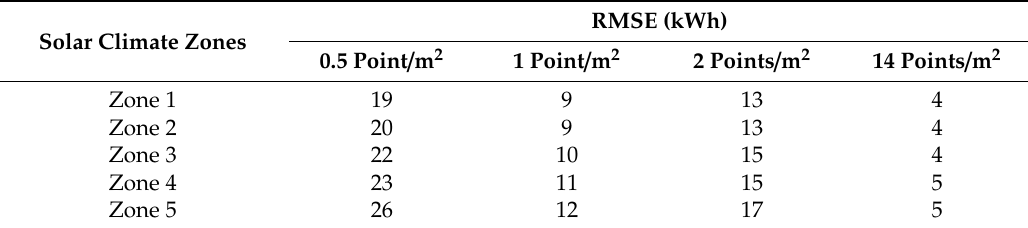
Table 17. Average daily PV energy production loss (kWh) due to the error in the estimation of the rooftop area for di ff erent point cloud densities: residential building with a gable roof of 400 m 2 .